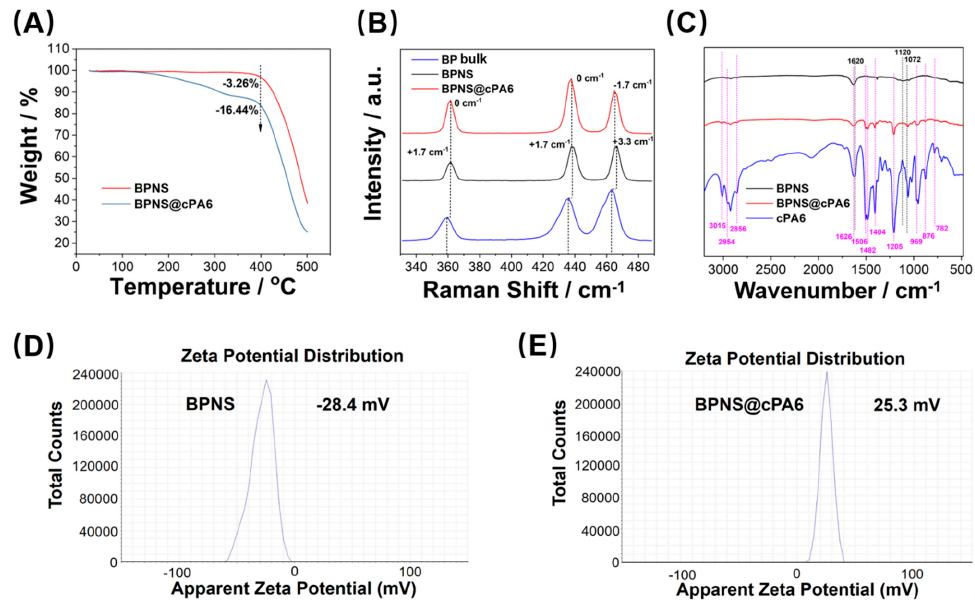
Figure 6. Characterization of black phosphorus nanosheets (BPNS) and BPNS@cPA6. (A